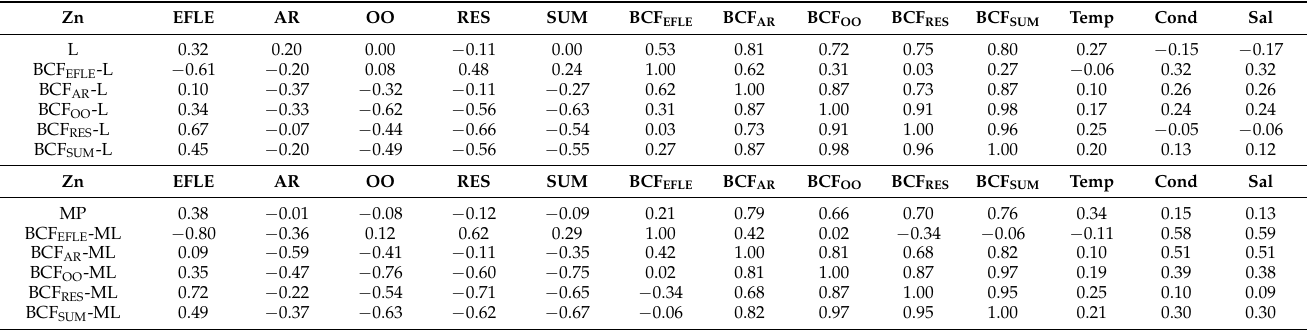
Table 2. Zinc correlation coefficients between variable A (Zn levels in the lamina and Fe biocon- centration factors (BCF)) and variable B (geochemical fractions in the sediments and surface water parameters). Values in red are significant at p <